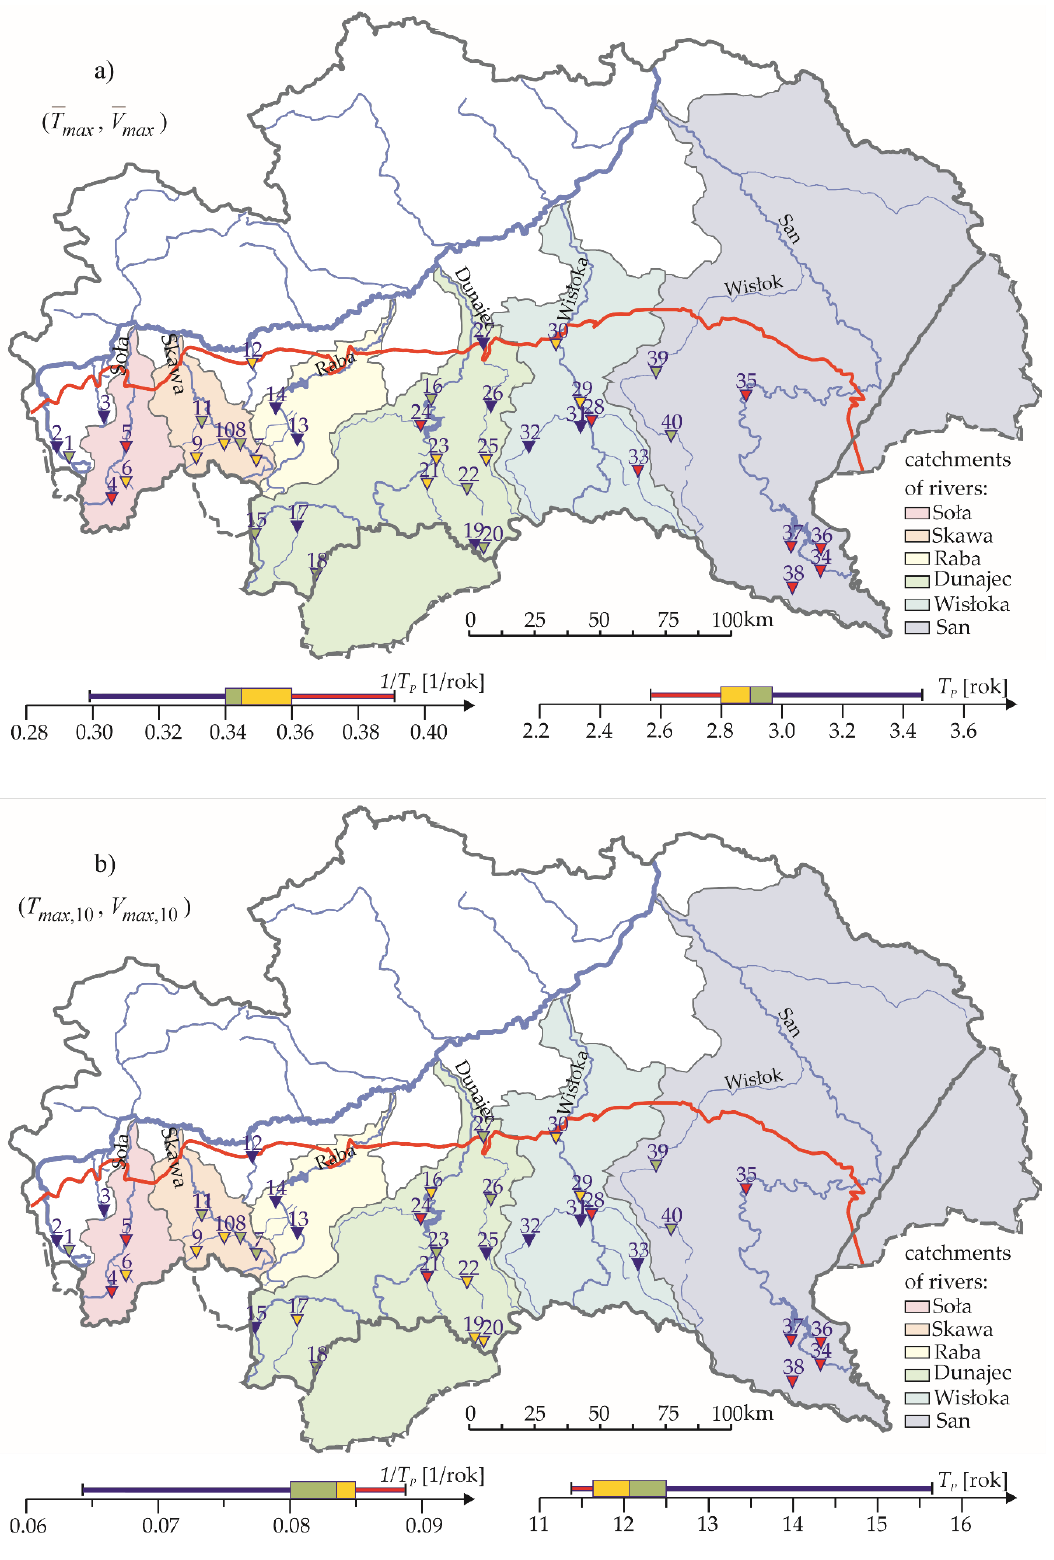
T V ; and ( b ) max max